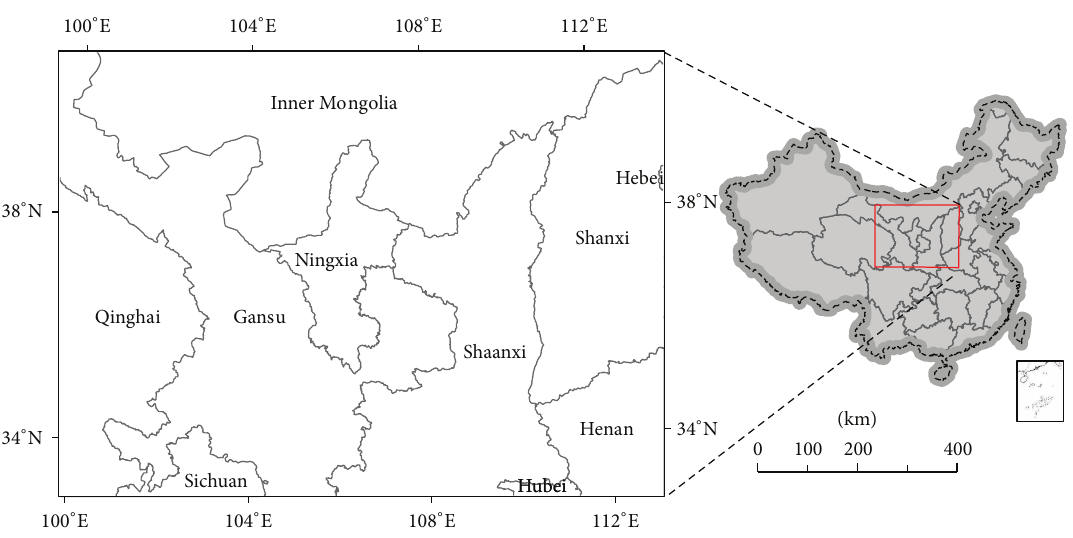
Figure 1: Location of the study